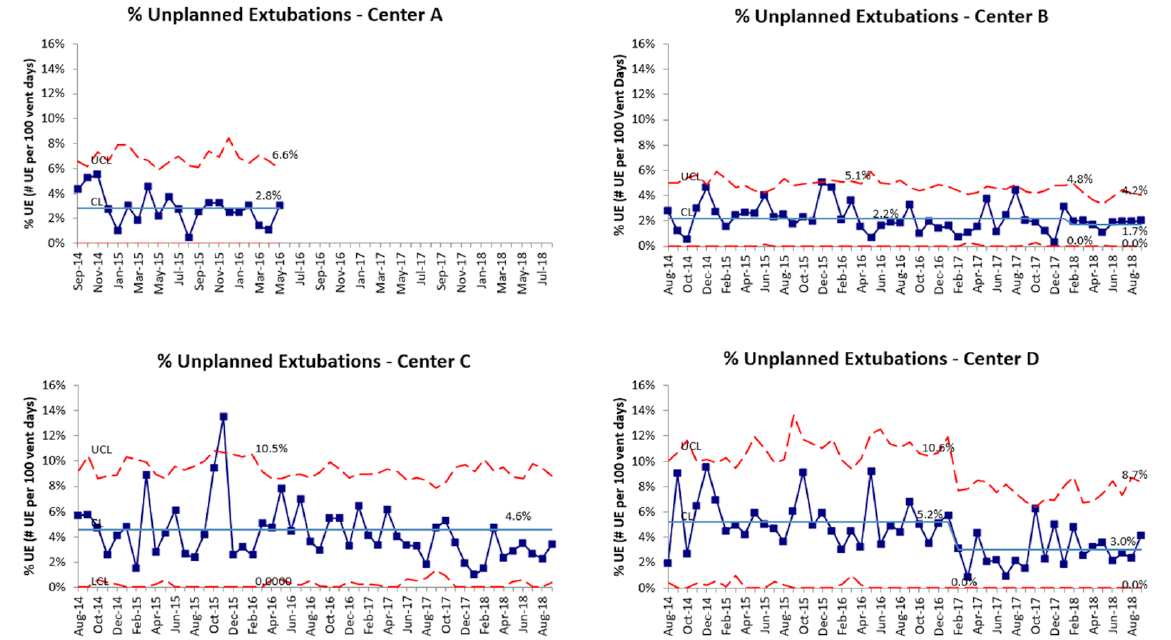
Figure 3. U-chart demonstrating the monthly combined UE rate for all centers. Special cause varia- tion (rule of shift) was noted beginning in February 2017. CL = center line (mean), UCL = upper control limit, and LCL = lower control limit.